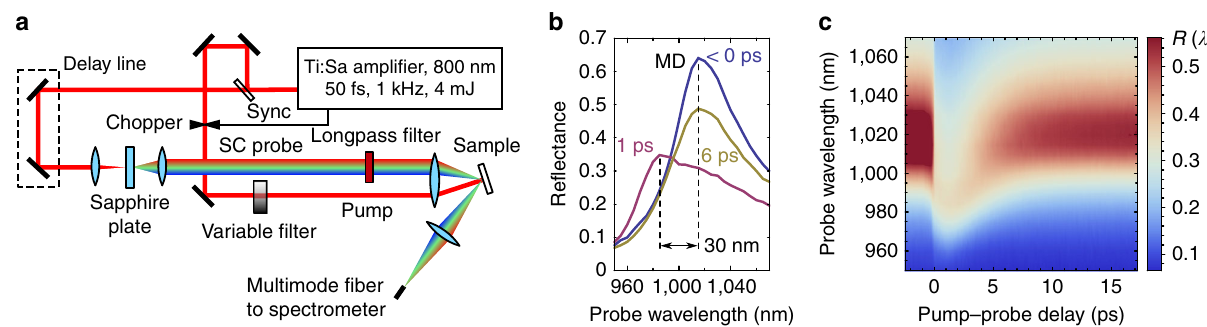
Fig. 2 Experimental ultrafast all-optical tuning of GaAs metasurfaces. a Setup for broadband pump – probe spectroscopy. Ampli fi ed femtosecond pulses are used both for pumping metasurfaces and for generation of the supercontinuum (SC) probe. Transients are measured as a function of both time delay between the pump and probe pulses and probe wavelength. b Experimental re fl ectance of the sample at different pump – probe delays. The MD mode blueshift of 30 nm is observed at a pump fl uence of 310 μ J cm − 2 . c Transient re fl ectance spectra that reveal the ultrafast modulation of the resonance within a 6-ps time window. Note that the re fl ectance values higher than 0.56 are clipped with the false-colour scale for the sake of better visualisation of the post-pump processes